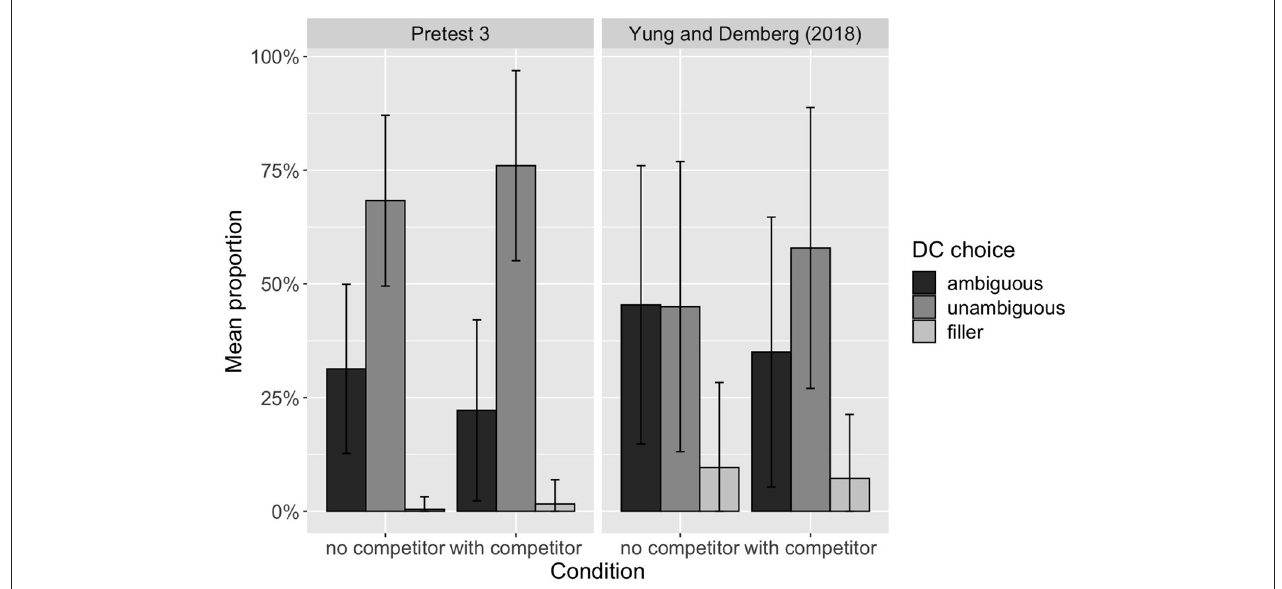
FIGURE 1 | Distribution of the proportion of DC choices made by each participant in the language game experiment of Pretest 3 and Yung and Demberg